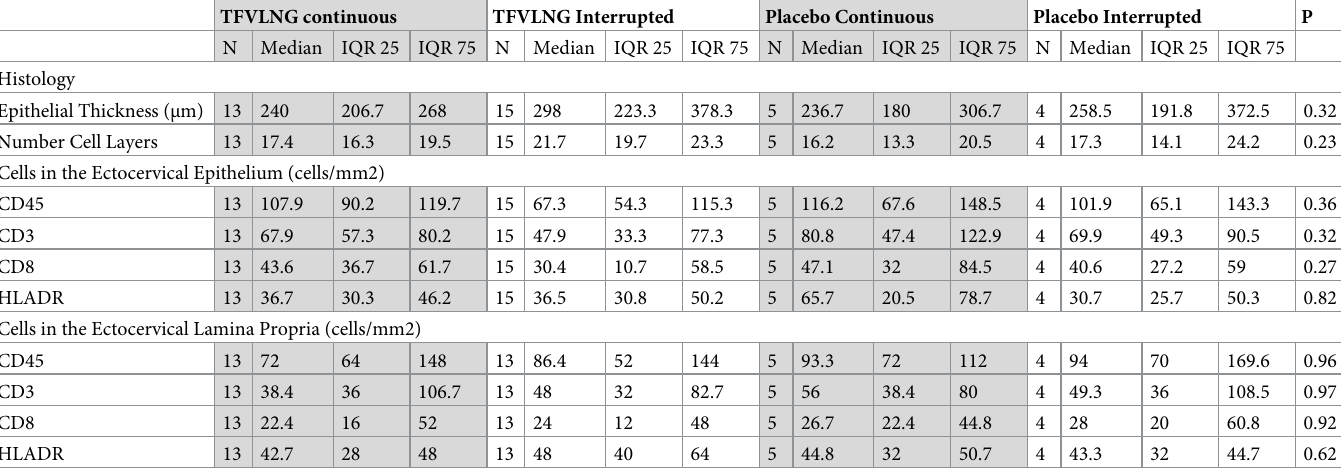
Table 3. Immune cells in ectocervical tissue at the end of treatment (visit 31) based on treatment and dosing assignment. TFVLNG continuous TFVLNG Interrupted Placebo Continuous